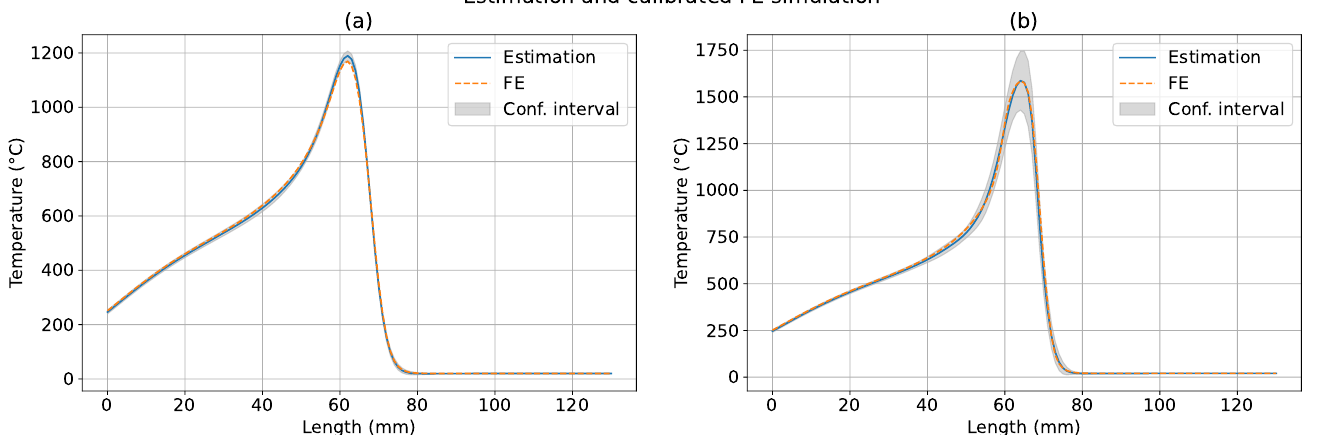
Figure 8. Temperature estimations obtained from noisy synthetic data, FE simulation and confidence interval. ( a ) Camera side. ( b ) Torch side.